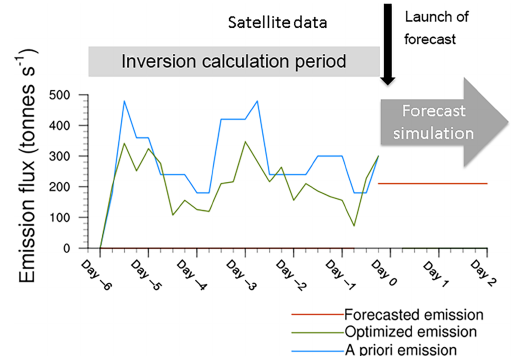
Figure 1. Scheme of how the evolution of ash emissions used in the eEMEP model simulations may look, with an a priori emission estimate, the calculated a posterior (optimized) emission estimate, and a forecast emission